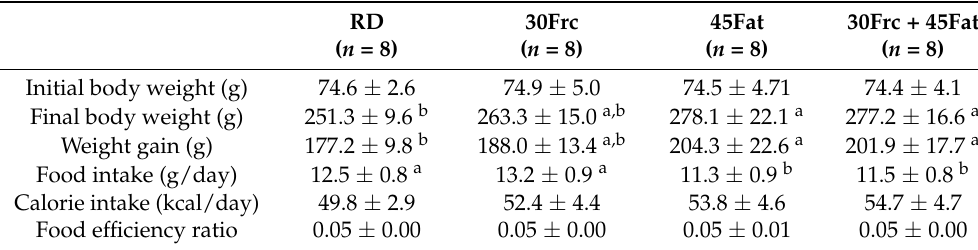
Table 2. Body weights, food intakes, calorie intakes, and food efficiency